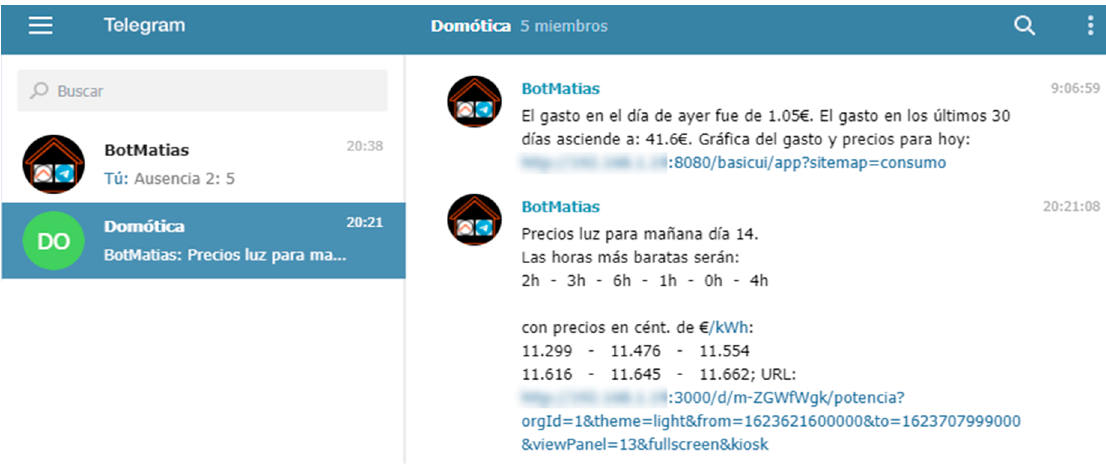
Figure 12. Data dashboard extract (Grafana + InfluxDB + MariaDB).